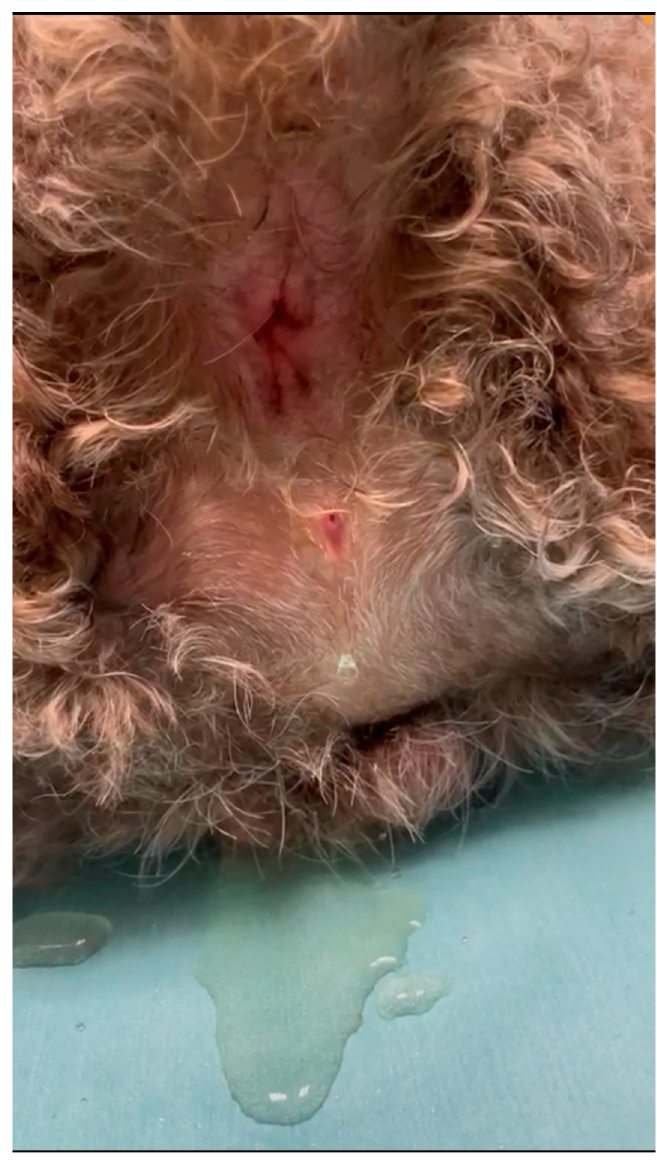
Figure 1. Note the small orifice, from which urine flows, below the anus. An abdominal ultrasound was performed, and no anomalies were found. Under general anesthesia, the penile urethra was catheterized, highlighting that the orthotopic urethra was functional. The retrograde hydropropulsion confirmed the access between the perineal orifice and the orthotopic urethra. To determine the extent of the accessory channel, a contrasted retrograde urethrocystography was performed. The post-administration